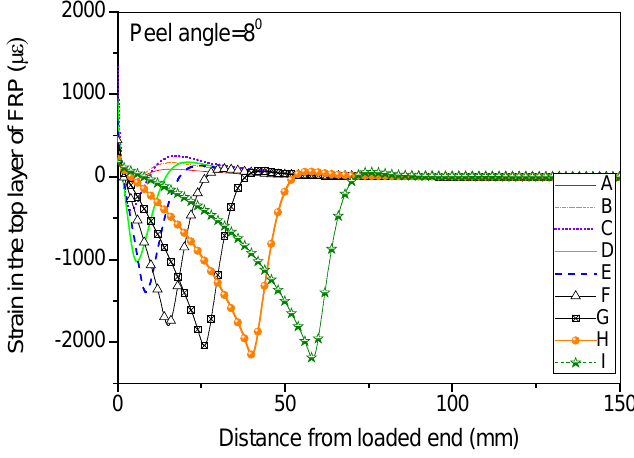
Figure 18. Strain distributions along the surface of FRP lamina when the peel angle = 8 degree.